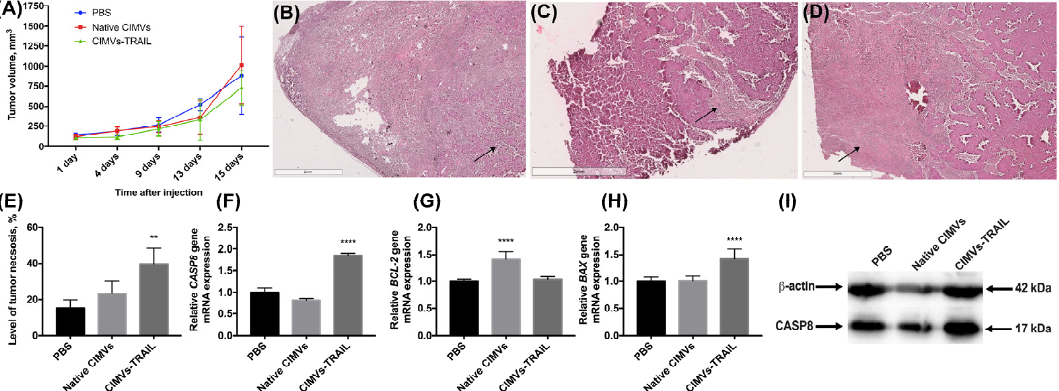
Figure 5. The antitumor activity of CIMVs-TRAIL was investigated in subcutaneous MCF-7 tumor xenograft mouse model. The injection of CIMVs-TRAIL did not lead to a decrease in the rate of tumor growth ( A ). However, the level of tumor tissue necrosis after injection of CIMVs-TRAIL was significantly higher ( n = 5, ** p < 0.01) compared to control tumors, as seen in H&E stained tumor sections ( B —PBS, C —native CIMVs; D —CIMVs-TRAIL), the percentage of necrotic tissue was calculated using ImageJ ( E ). At the same time, the mRNA level of the CASP8 gene in the CIMV-TRAIL group was increased by 1.8 times ( F ), the level of the antiapoptotic BCL-2 gene remained unchanged ( G ), and the mRNA level of the proapoptotic BAX gene was increased by 1.4 times ( H ). An increase in the level of a key protein involved in the process of apoptosis, CASP8, in activated form ( I ) was also observed. Each box represents the mean ± SD ( n = 5) of five replicates. ** p < 0.01; **** p < 0.0001.